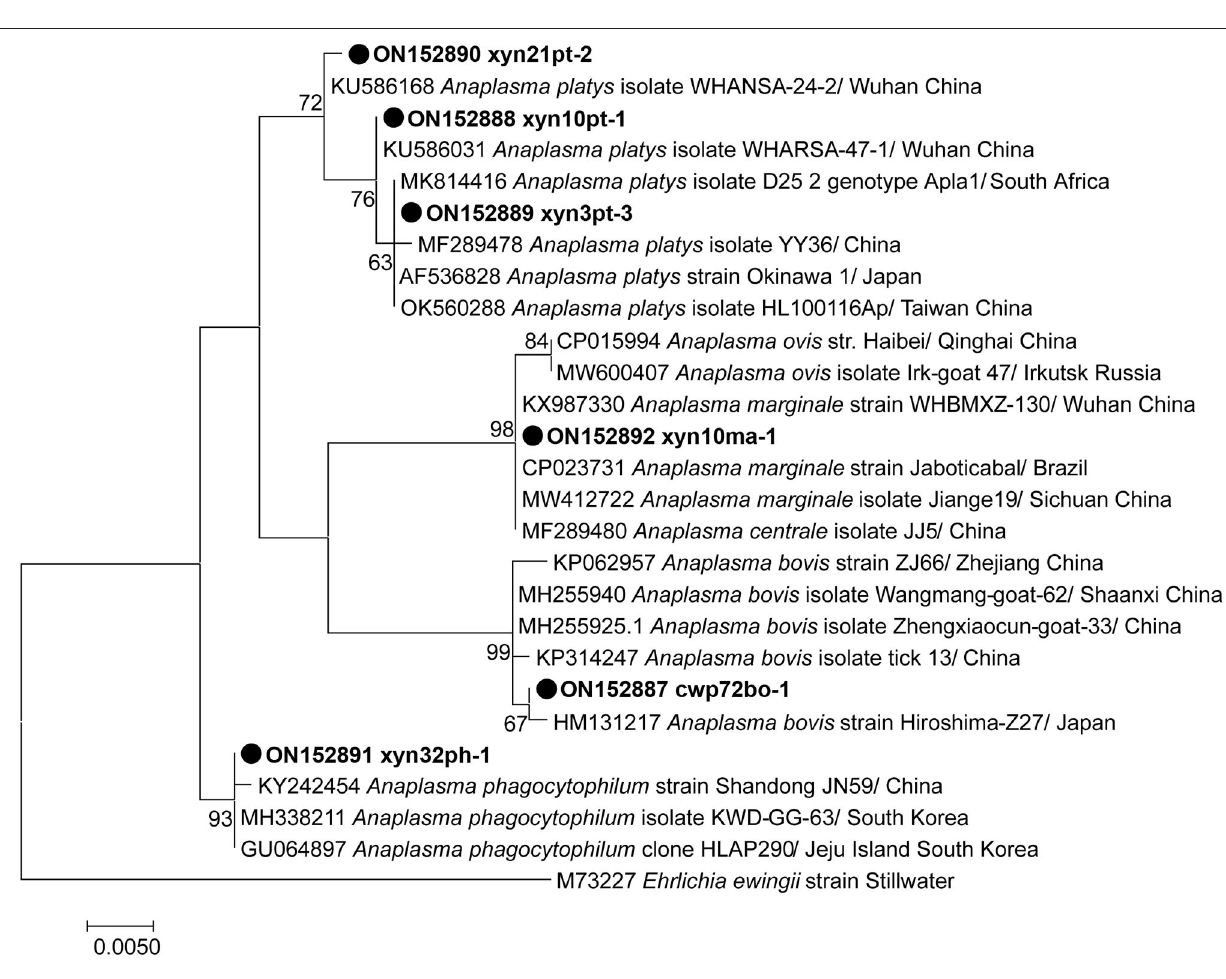
FIGURE 2 | Phylogenetic tree of Anaplasma species based on partial rrs gene sequence. The sequences obtained in this study are indicated with black dots. The phylogenetic tree was generated using the maximum likelihood method with 1,000 replicates for bootstrap testing in MEGA 7.0 software. Only bootstrap values > 50% are shown. The scale bar indicates nucleotide substitutions per site. The species, locations, and GenBank accession numbers of the reference sequences are shown in each line. spp. was detected in 0% (0/32) of the brain samples, 25% (8/32) (14/32) were Anaplasma -positive, which was significantly higher of the spleen samples, 25% (8/32) of the lung samples, 18.8% than that in their parasitic ticks ( χ 2 = 14.2, P < 0.001). Different (6/32) of the liver samples, 15.6% (5/32) of the heart samples, positive rates were found in different organs. Briefly, Anaplasma